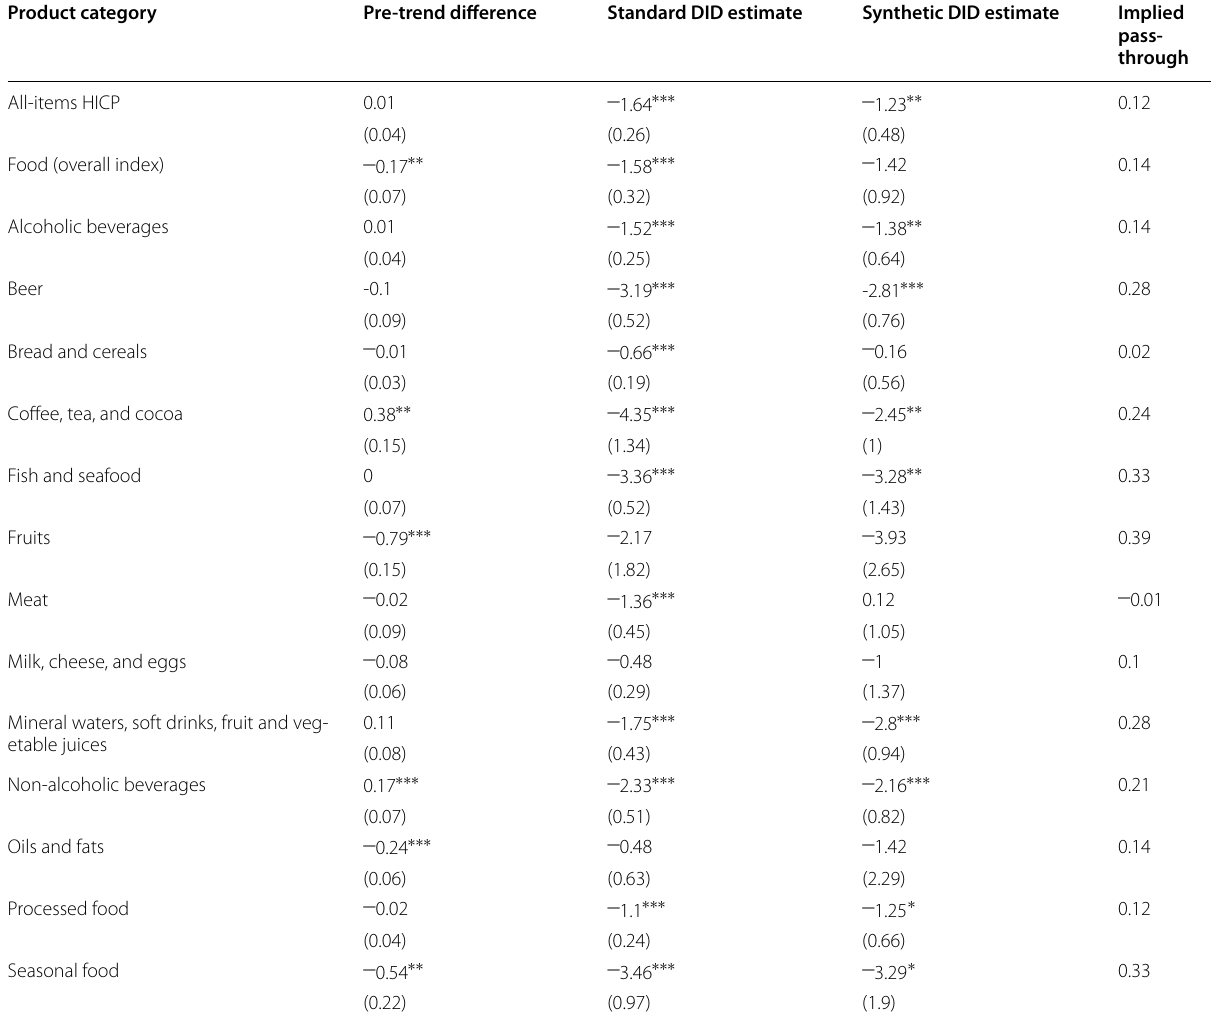
Table 5 Estimates of the exchange rate pass-through to consumer prices for Food &